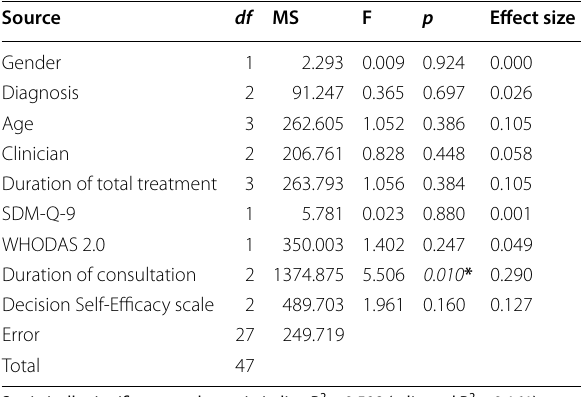
Statistically significant results are in italics, R 2 MS mean squares, effect size